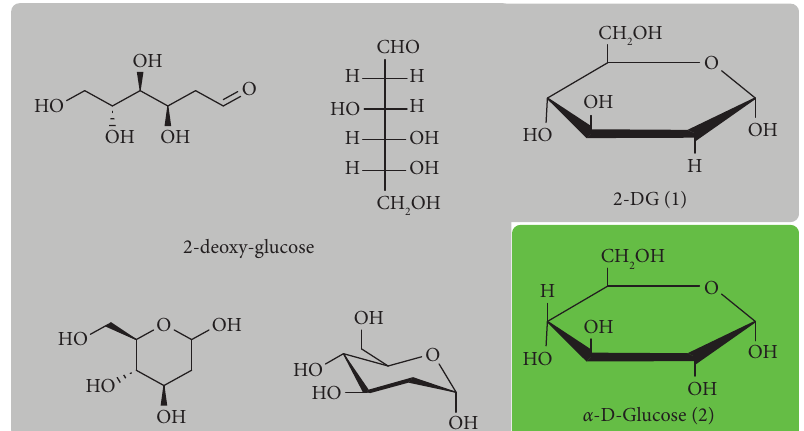
Figure 1: Structure of 2-deoxy-D-glucose (CAS: 154-17-6), synonyms: 2-DG; 2-deoxy-D-arabino-hexose;